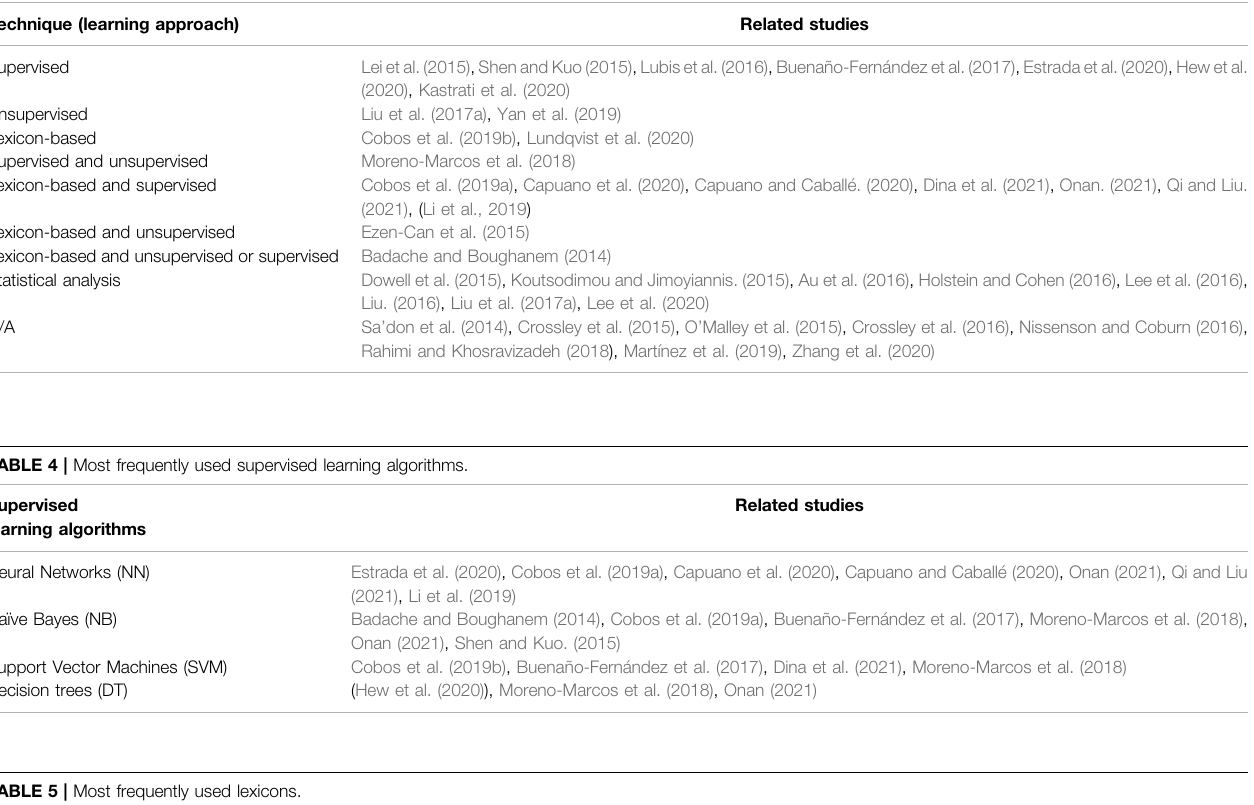
TABLE 5 | Most frequently used lexicons.